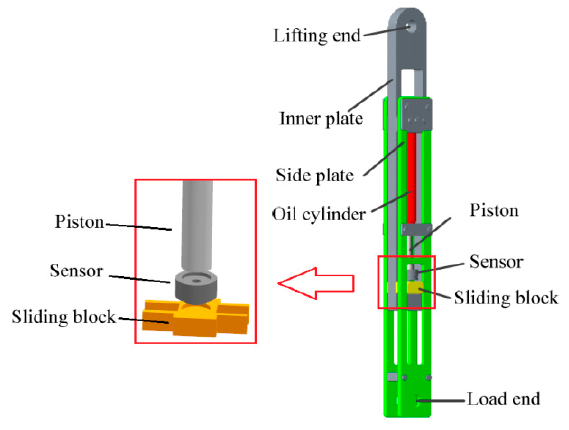
Figure 2. The balance cylinder model of a hoist.